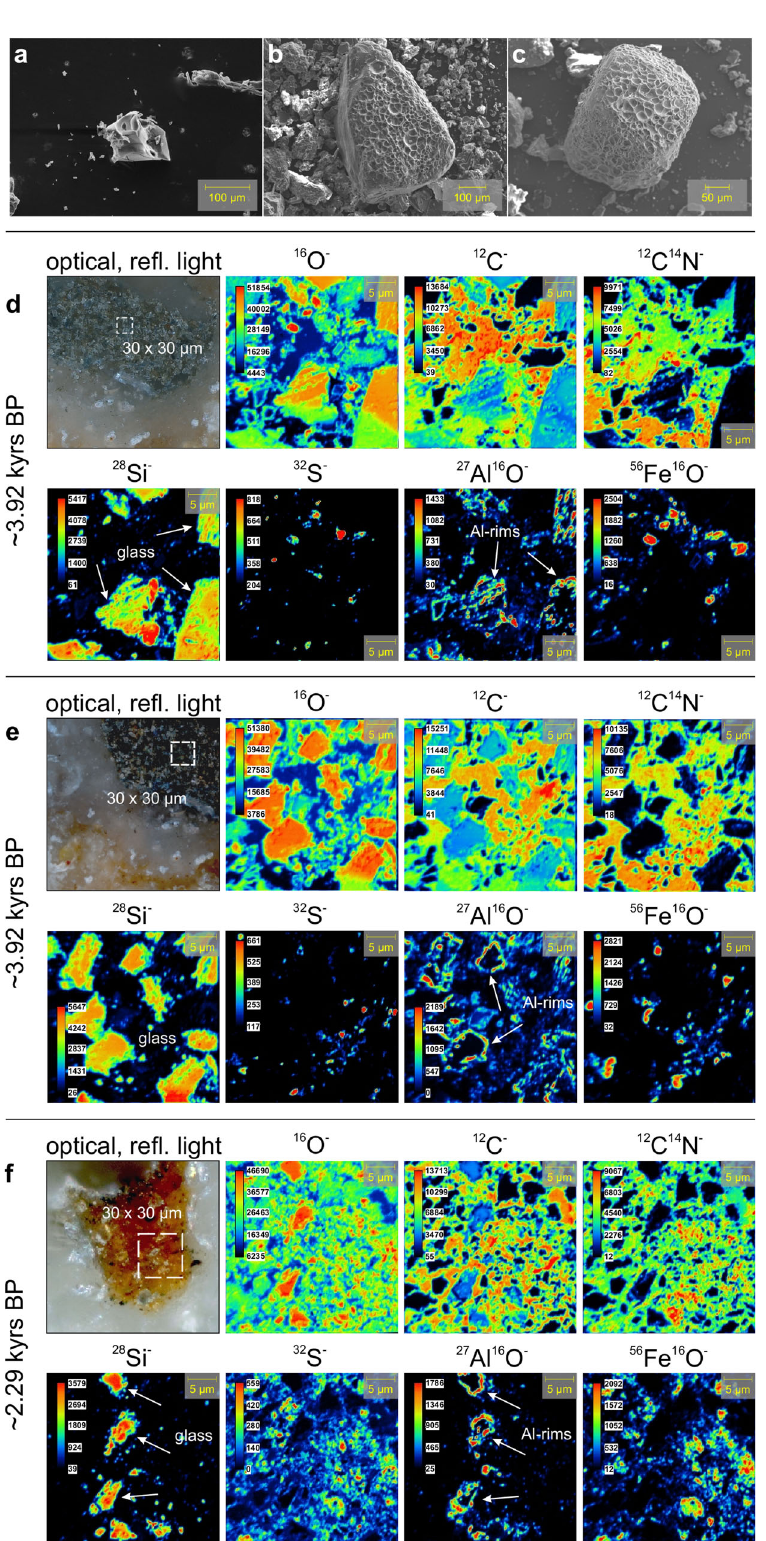
Fig. 7 Glass shards and phenocrysts from Mt. Burney tephra detected in laminae of MA1. SEM micrographs show a glass shard ( a 2.20 kyrs BP) and phenocrysts coated with residual, vesicle-rich volcanic glass ( b , c 4.15 kyrs BP) incorporated in MA1. d – f NanoSIMS secondary ion mappings indicate the presence of more intact fi ne-grained glass fragments framed by rims of elevated 27 Al 16 O − counts in OM-rich accumulation pools from laminae at ~3.92 and ~2.29 kyrs